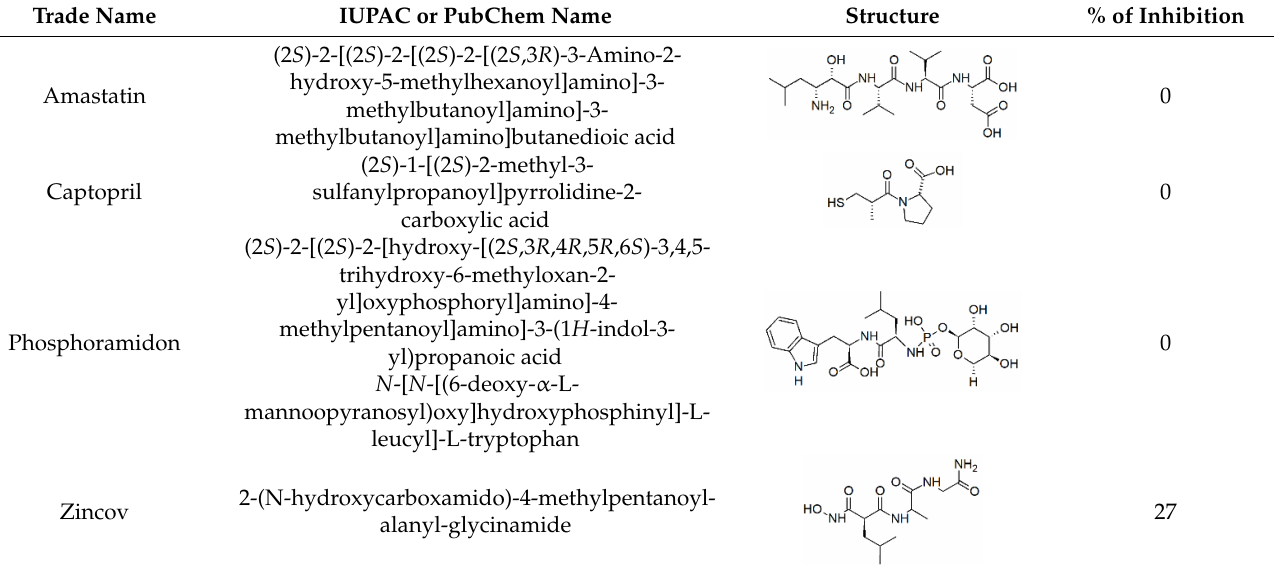
Table 2. Selectivity of human collagenases inhibition, among available inhibitors of metalloproteases (by Moore and Spilburg) [63].